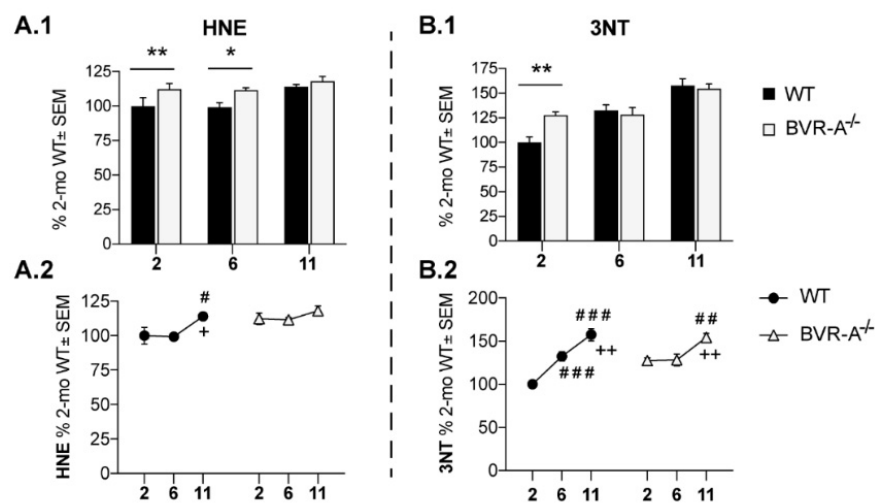
Figure 1. Increased oxidatively-damaged proteins accumulation in the cerebral cortex of Biliverdin reductase-A (BVR-A − / − ) mice. Slot Blot quantification of 4-hydroxy-2-nonenal (HNE) ( A.1 , A.2 ) and 3-NT levels ( B.1 , B.2 ) evaluated in the cerebral cortex of wild-type (WT) and BVR-A − / − mice at 2 ( n = 4), 6 ( n = 4) and 11 ( n = 4) months of age. Data are expressed as percentage of WT mice at 2 months set as 100%. Columns were used to show differences among the groups (WT vs. BVR-A − / − ) while dots to show age-associated changes within each group. Data are expressed as Mean ± SEM. For columns: * p < 0.05, ** p < 0.01 vs. WT (2-way ANOVA with Fisher’s LSD test). For dots: # p < 0.05, ## p <0.01, ### p < 0.001 vs. 2 months; + p < 0.05, ++ p < 0.01 vs. 6 months (2-way ANOVA with Fisher’s LSD test). Table 1. 2-way ANOVA analysis of western blot data for the identification of the influence of age and genotype on the differences observed between WT and BVR-A − / − mice at 2, 6 and 11 months of age. Age Genotype (WT-BVR-A − / − ) Interaction F (DFn, DFd) p F (DFn, DFd) p F (DFn, DFd) p 2-WAY ANOVA HNE F (2, 18) = 5.18 p < 0.05 n.s. n.s n.s. n.s. Target of 3-NT F (2, 18) = 28,70 p < 0,0001 p < 0,05 Analysis p-mTOR F (2, 18) = 10.53 p < 0.001 F (1, 18) = 40.78 p < 0.0001 n.s. n.s.